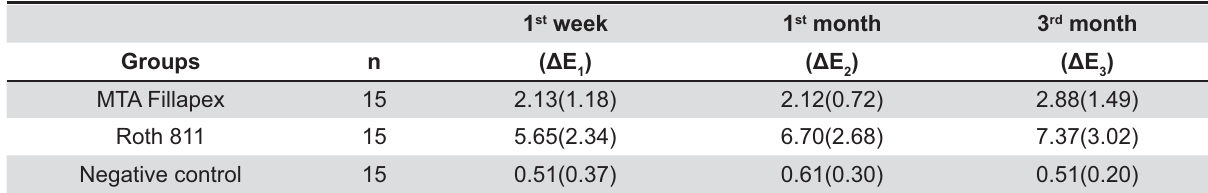
Table 2- (cid:14)%(cid:6)(cid:10)(cid:3)(cid:14)(cid:24)(cid:11)(cid:10)(cid:3)(cid:7)(cid:10)(cid:17)(cid:7)(cid:14)(cid:7)(cid:6)(cid:13)(cid:12)(cid:10)(cid:11)(cid:12)(cid:16)(cid:3)(cid:14)&’(cid:14)(cid:13)(cid:10)(cid:5)(cid:21)(cid:6)(cid:24)(cid:14)(cid:16)(cid:27)(cid:14)+(cid:17)(cid:16)(cid:21)(cid:22)(cid:24)(cid:14)$(cid:20)/(cid:14)(cid:12)(cid:3)(cid:14)(cid:10)(cid:5)(cid:5)(cid:14)(cid:6)(cid:31)(cid:22)(cid:6)(cid:17)(cid:12)(cid:23)(cid:6)(cid:3)(cid:11)(cid:10)(cid:5)(cid:14)(cid:22)(cid:6)(cid:17)(cid:12)(cid:16)(cid:7)(cid:24)